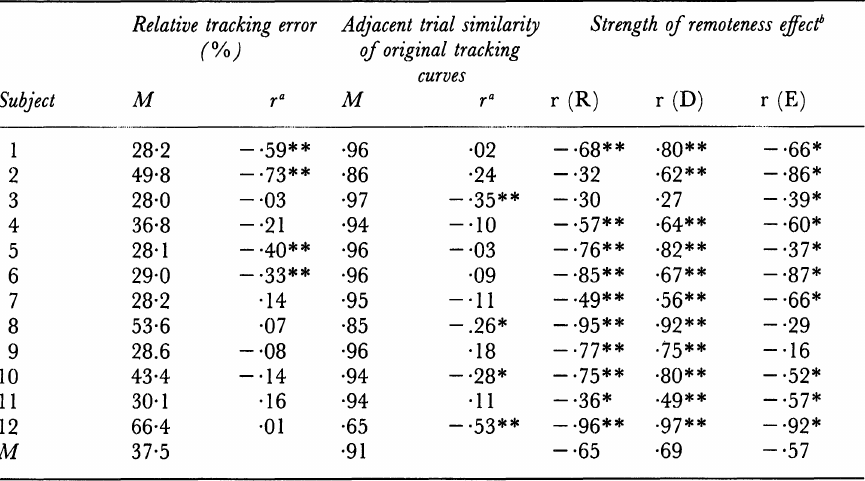
TABLE l. Tracking error and remoteness effect in random pursuit tracking (experiment 1, n = 12). Relative tracking error Adjacent trial similarity Strength of remoteness effecF (%) of original tracking curves